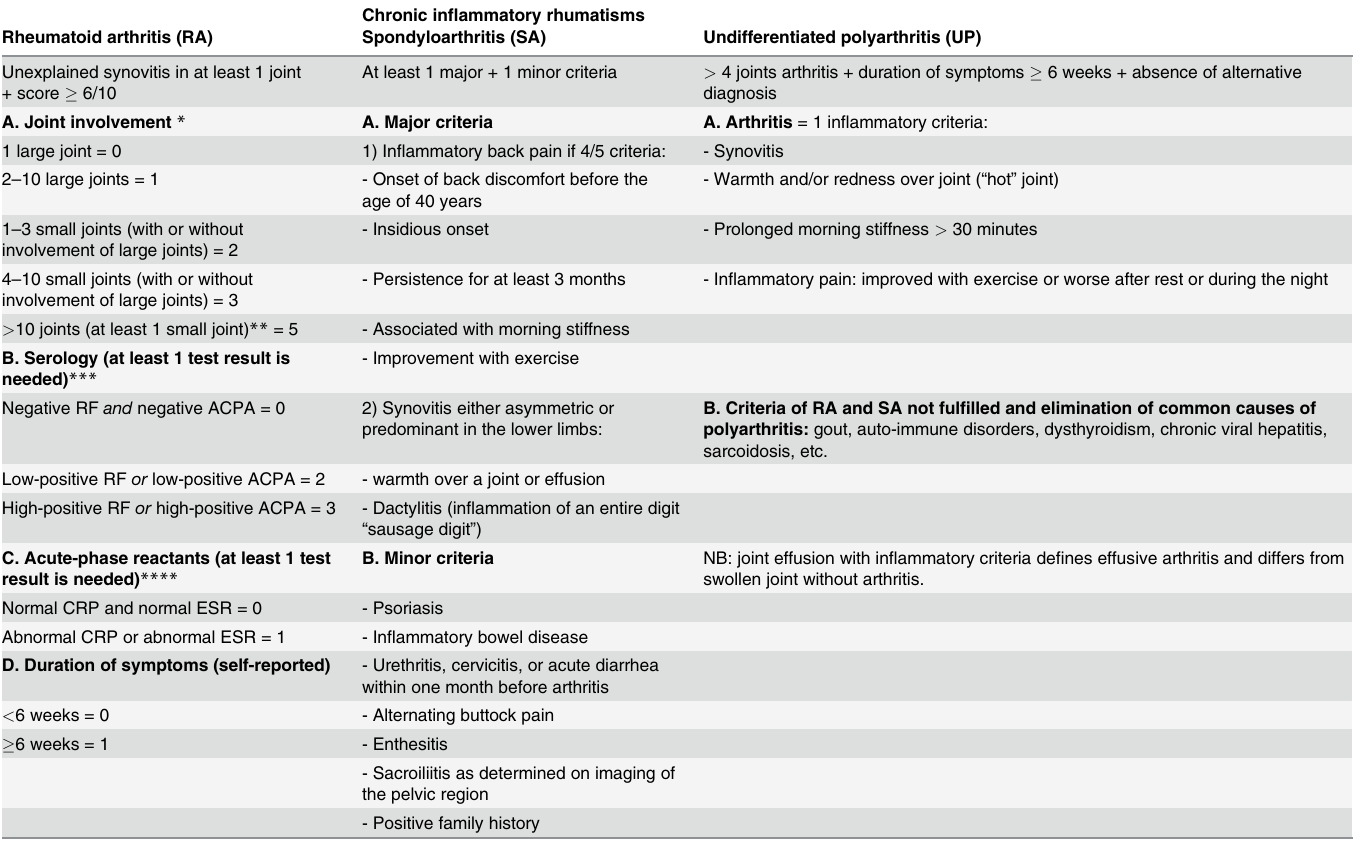
Table 1. De fi nitions of chronic in fl ammatory rheumatisms (CIR): rheumatoid arthritis according to the 2010 American College of Rheumatology/European League Against Rheumatism (ACR/EULAR) criteria [37]; spondyloarthritis according the European Spondyloarthropathy Study Group (ESSG) Classi fi cation [38]; undifferentiated polyarthritis (own study criteria). Chronic in fl ammatory rhumatisms Rheumatoid arthritis (RA) Spondyloarthritis (SA) Undifferentiated polyarthritis